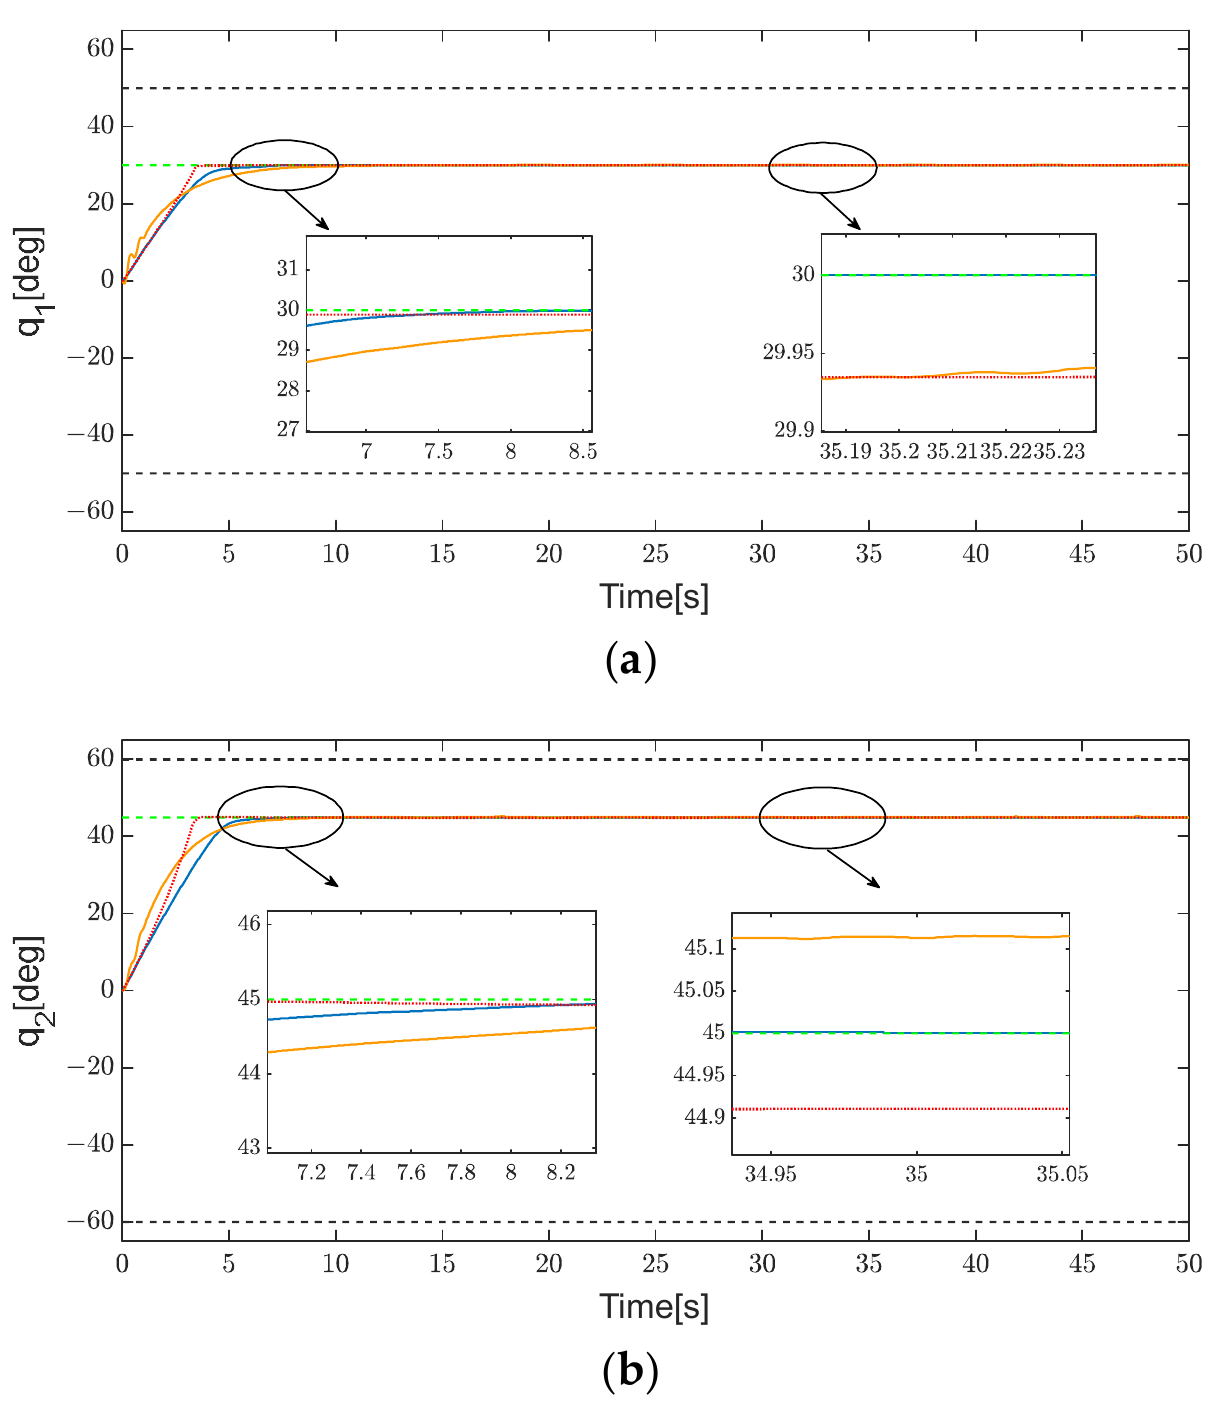
Figure 12. Comparison of angular position error to [43,44] in case 2: the [43] scheme (yellow solid line), the [44] scheme (red dash line), the proposed scheme (blue solid line); ( a ) Joint 1. ( b ) Joint 2.